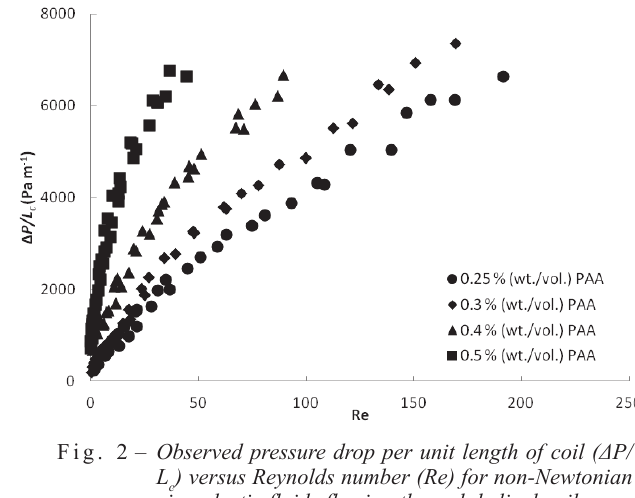
Table 2 – Physical and rheological properties of test fluids Test fluid ρ PAA (0.25 % wt/vol.)